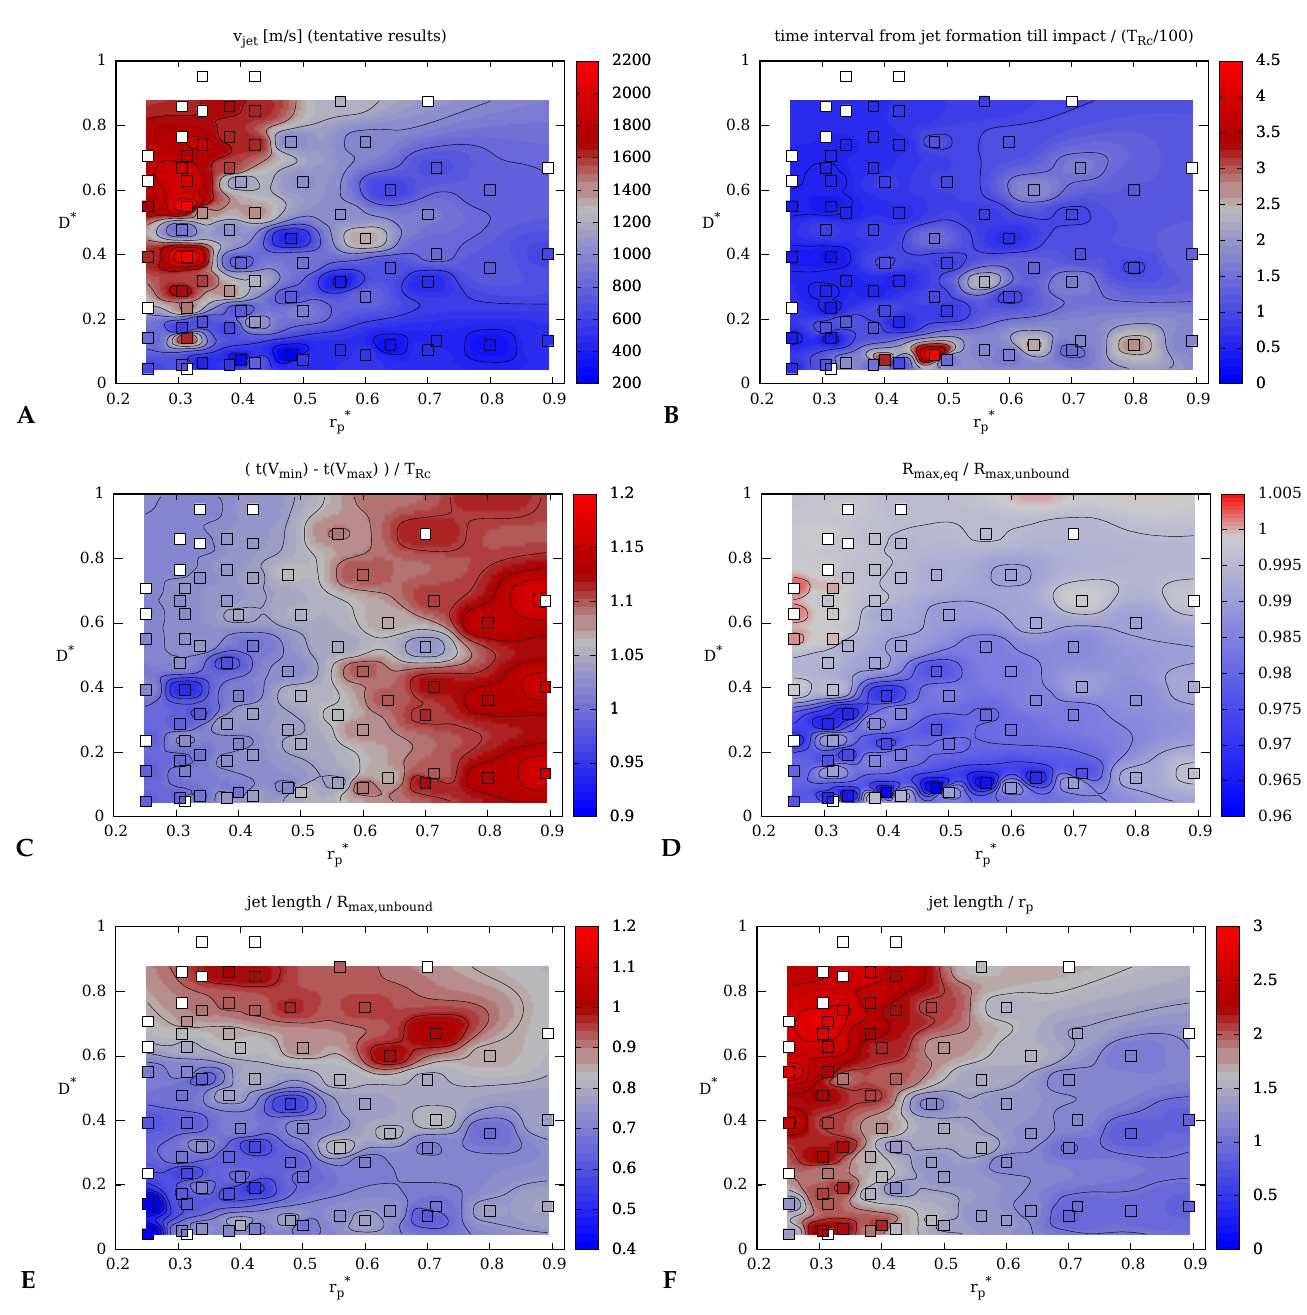
Figure 20. Extracted quantities from the parameter study including data points for both r p = 160µm and r p = 200µm. Plotted are ( A ) the tentative results of the jet velocity for the given mesh (results may differ substantially for other meshes), ( B ) the tentative results of the time interval from jet formation till jet impact for the given mesh (results may differ substantially for other meshes), ( C ) the collapse time normalized by the Rayleigh collapse time, the number being called the prolongation factor, ( D ) the actual, equivalent maximum bubble radius normalized by R max,unbound , ( E ) the jet length normalized by R max,unbound , ( F ) the jet length normalized by the cylinder radius r p . White data points denote cases, where either the bubble dynamics was different from the mushroom case or a standard jet by involution of the bubble wall was